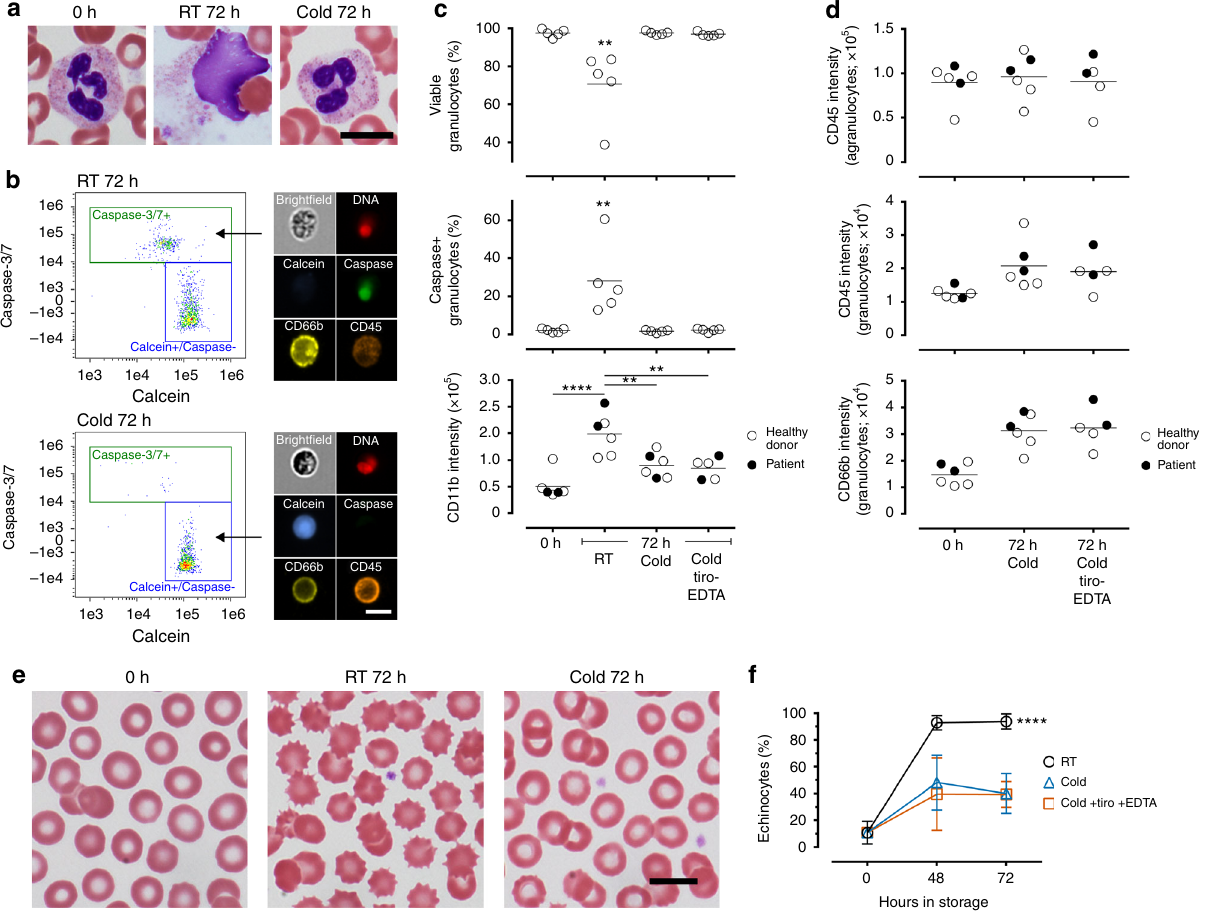
Fig. 1 Hypothermic storage of ACD-anticoagulated blood preserves the viability and integrity of diverse cell types. a Representative images of neutrophils in fresh (0 h) and stored (72 h) blood. Storage in RT leads to cell death and release of nuclear materials, whereas storage in 4 °C (cold) preserves cellular integrity and the distinct segmented nuclear morphology. b Imaging fl ow cytometry for the quanti fi cation of viable (calcein+/caspase − ) and apoptotic (caspase+) leukocytes as well as surface marker expression. c Percentages of viable and apoptotic granulocytes (CD45+/CD66+), and their expression of CD11b in fresh and stored blood (** p < 0.01; **** p < 0.0001; one-way ANOVA followed by Tukey ’ s post test). d Surface expression of CD45 and CD66b on agranulocytes (CD45+/CD66b − ) and granulocytes. e Representative images of RBCs in fresh and stored blood. Echinocytes are identi fi ed by the distinct spiculations as shown in RT-stored blood. f Percentages of echinocytes as a function of storage (**** p < 0.0001; two-way ANOVA followed by Tukey ’ s post test). c , d , f The platelet stabilization cocktail treatment (tiro-EDTA) does not affect cell viability, activation, marker expression, or echinocyte formation. All scale bars represent 10 μ m. Error bars represent